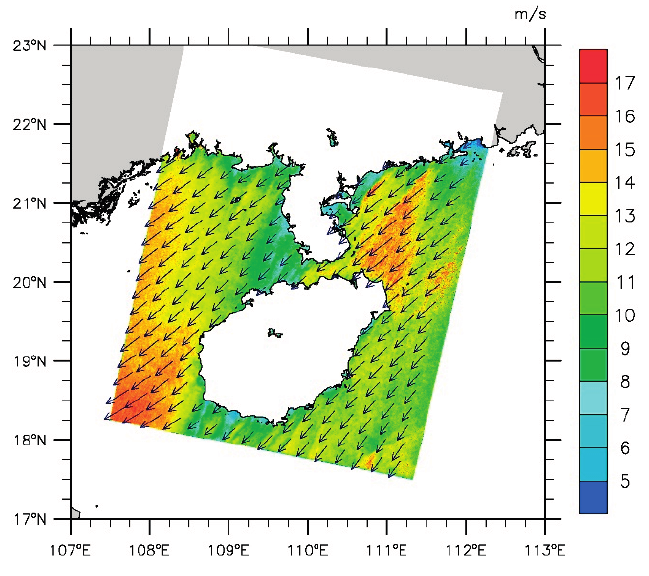
Figure 2. Wind field retrieved from ENVISAT ASAR WSM data for 2 November 2009 at 02:36 UTC.